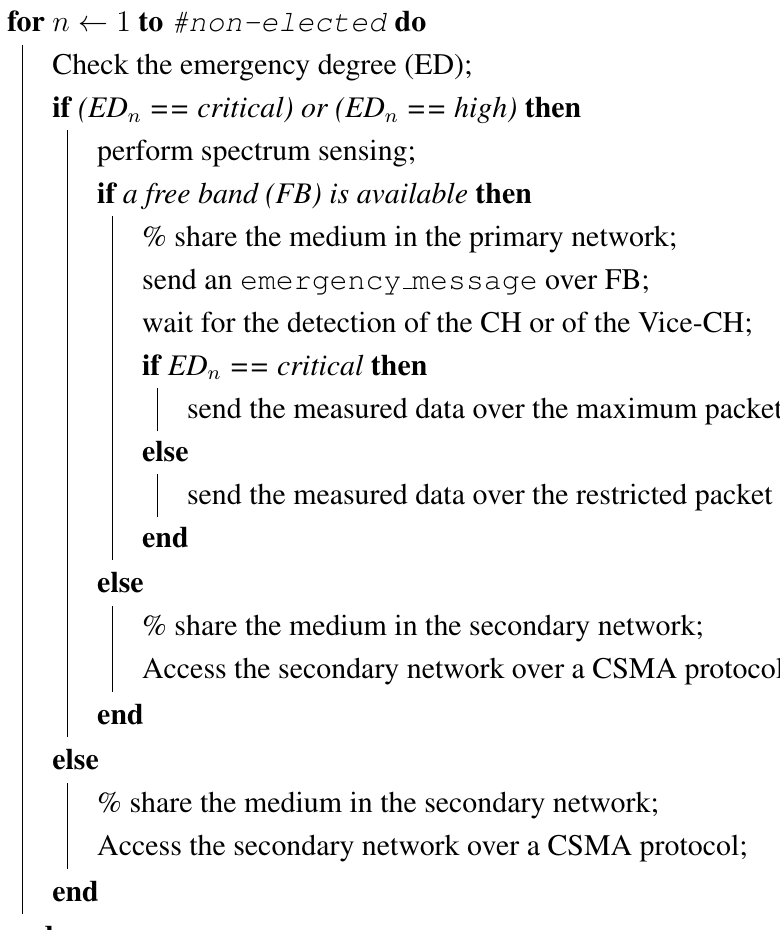
Algorithm 2: The emergency reporting performed inside a